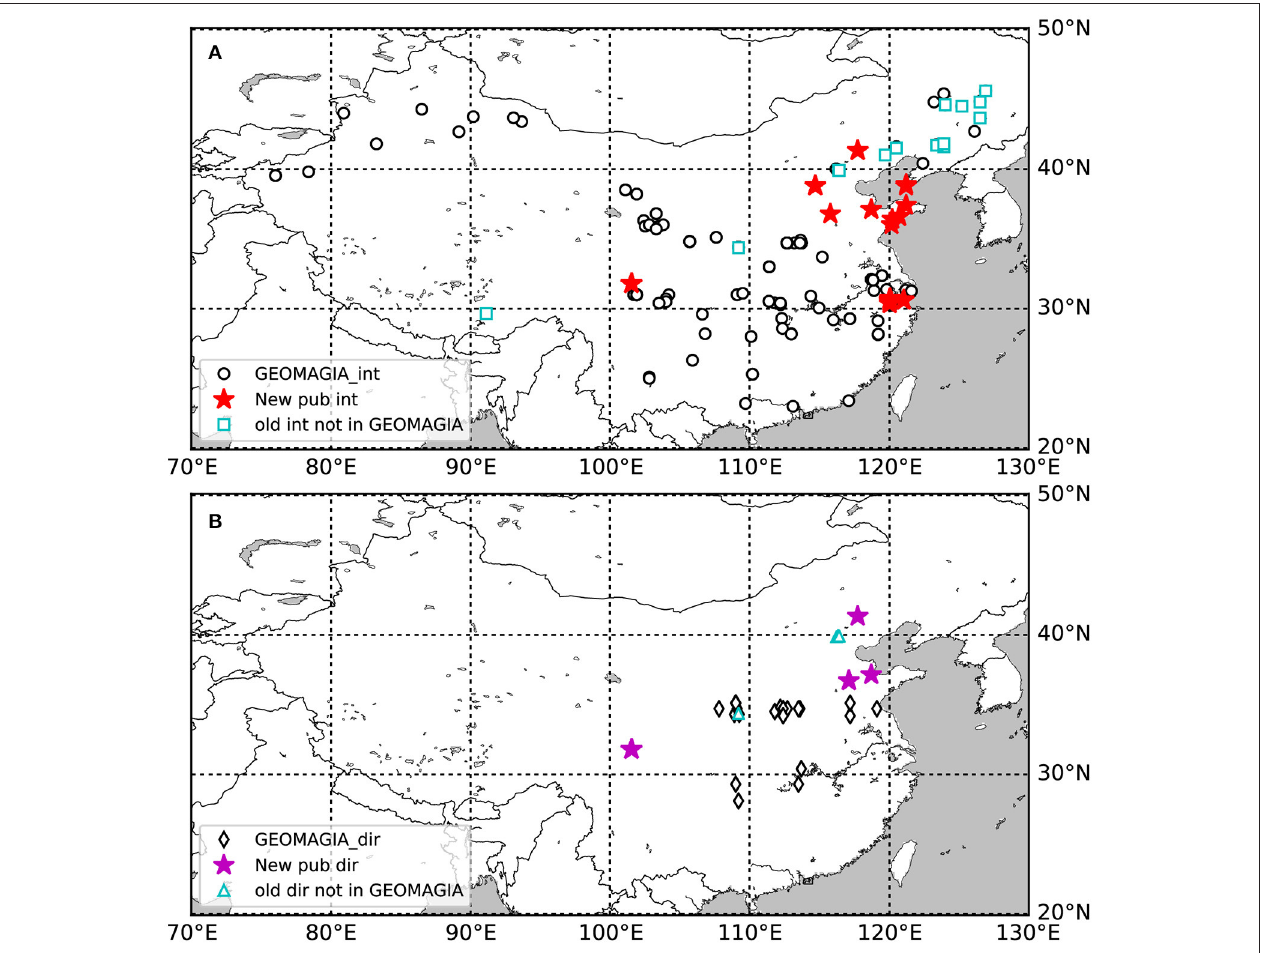
FIGURE 1 | Sitemap of all the published archeointensity (A) and archeodirection (B) data in China. “GEOMAGIA_int” and “GEOMAGIA_dir” represent locations of published archeointensity and archeodirection data from the GEOMAGIA50.v3 database. “New_pub int” and “New_pub dir” represent locations of archeointensity and archeodirection data published in the recent years ( Cai et al., 2014, 2015, 2016, 2017). “old int not in GEOMAGIA” and “old dir not in GEOMAGIA” represent locations of archeointensity and archeodirection data published in the twentieth century but not included in the GEOMAGIA database ( Deng and Li, 1965; IGCAS, 1977; Wei et al., 1980; Yang et al.,